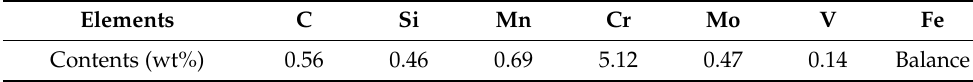
Table 1. Chemical composition of Cr5